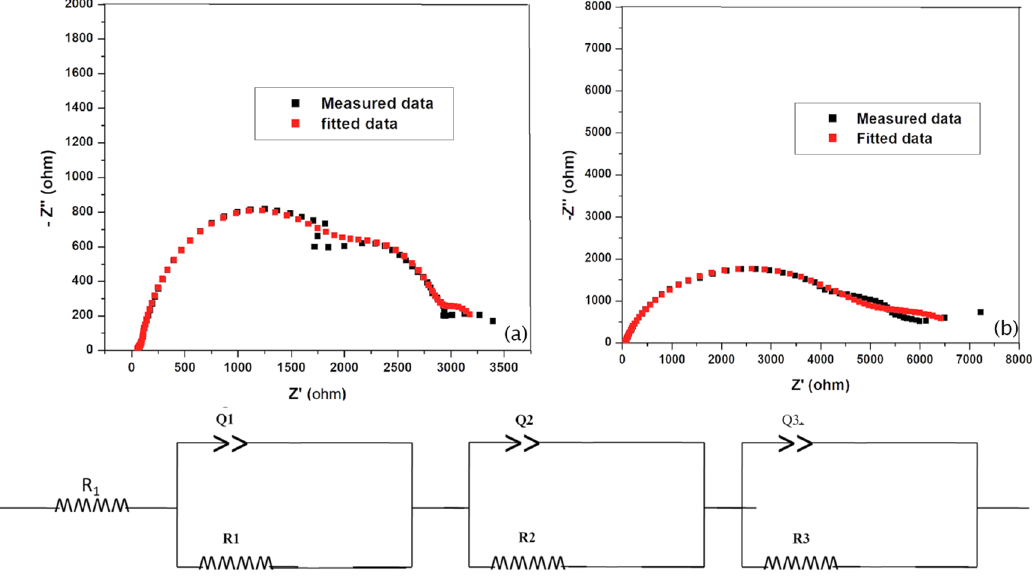
Figure 6. EIS analysis of synthesized ( a ) TiO 2 , ( b ) Ba/TiO 2 photoanode and along with the equivalent circuit of corresponding EIS.